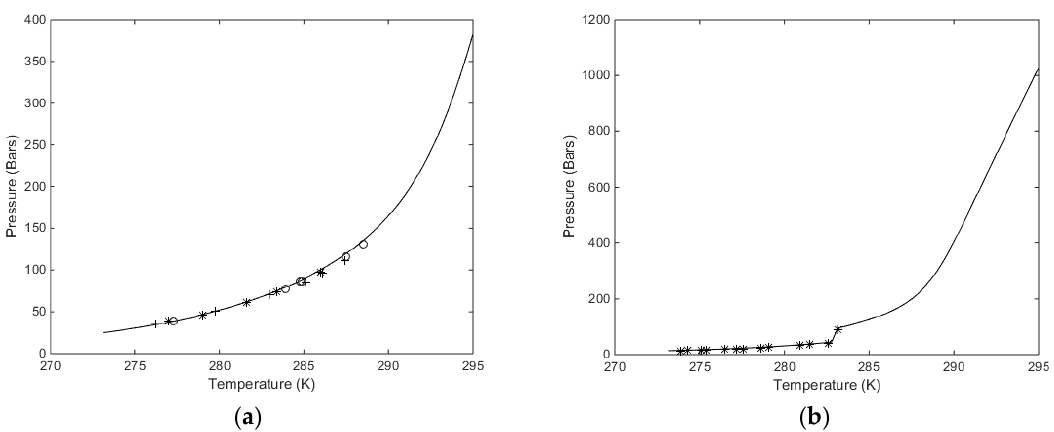
Figure 2. ( a ) Equilibrium curve for CH 4 hydrate. Calculated values (solid) and experimental data from Bavoh et al. [22] (*), Tumba et al. [23] (+) and Sabil et al. [24] (o). ( b ) Calculated equilibrium curve for CO 2 hydrate (solid) as compared to experimental data from Herri et.al. [25]